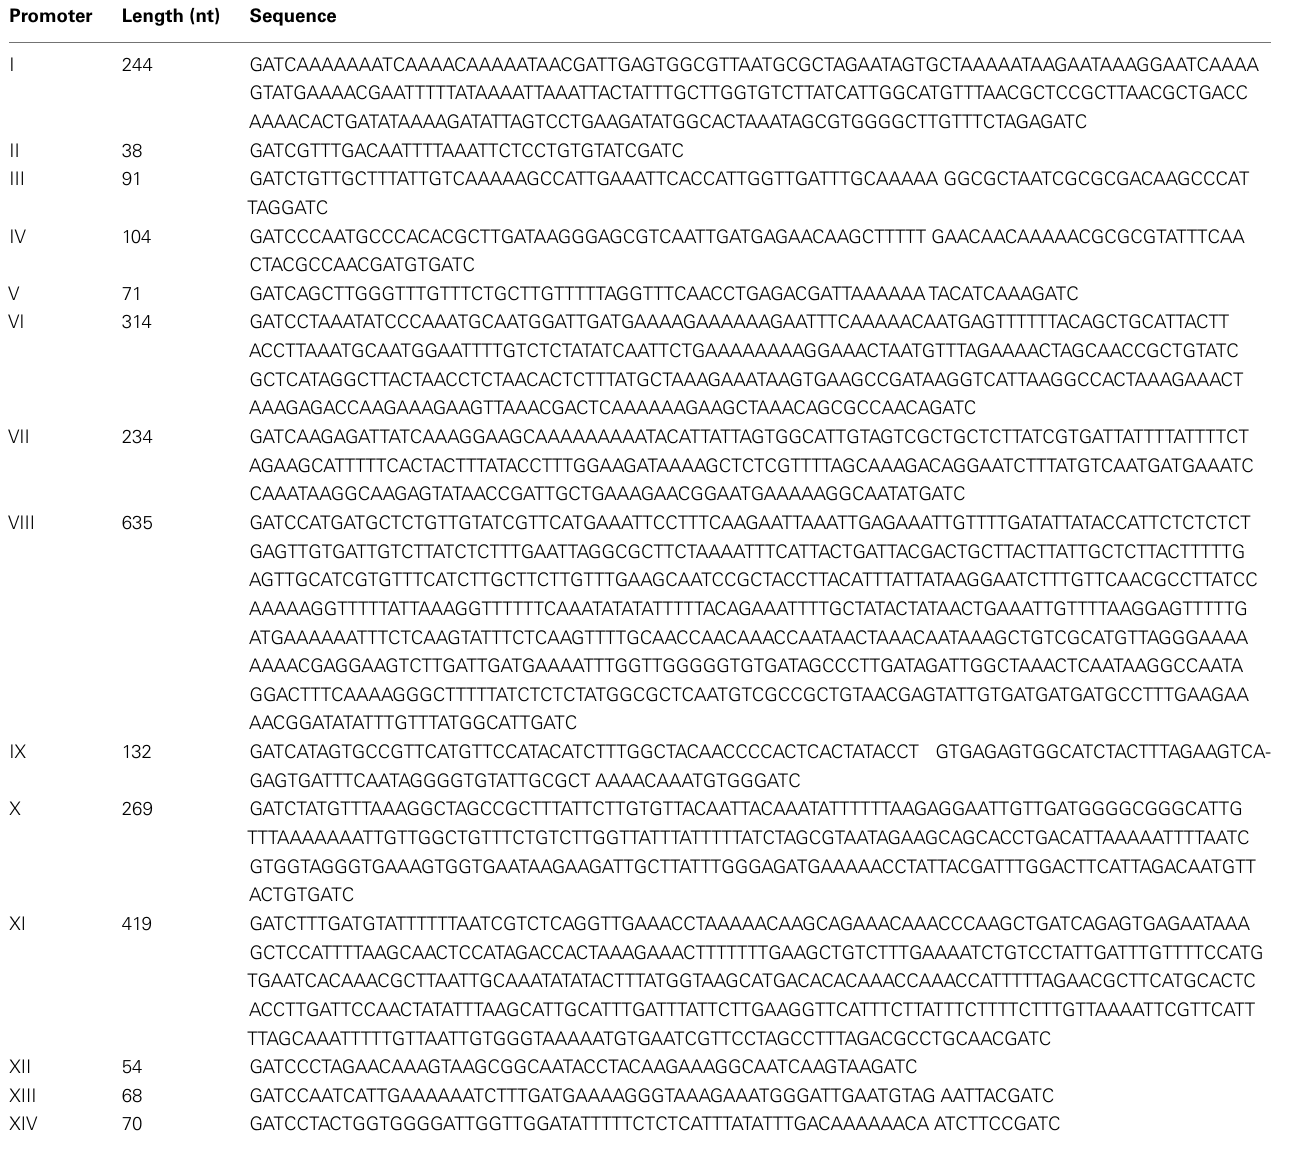
TableA5 | Putative promoter sequences that direct expression of the reporter tnpR .